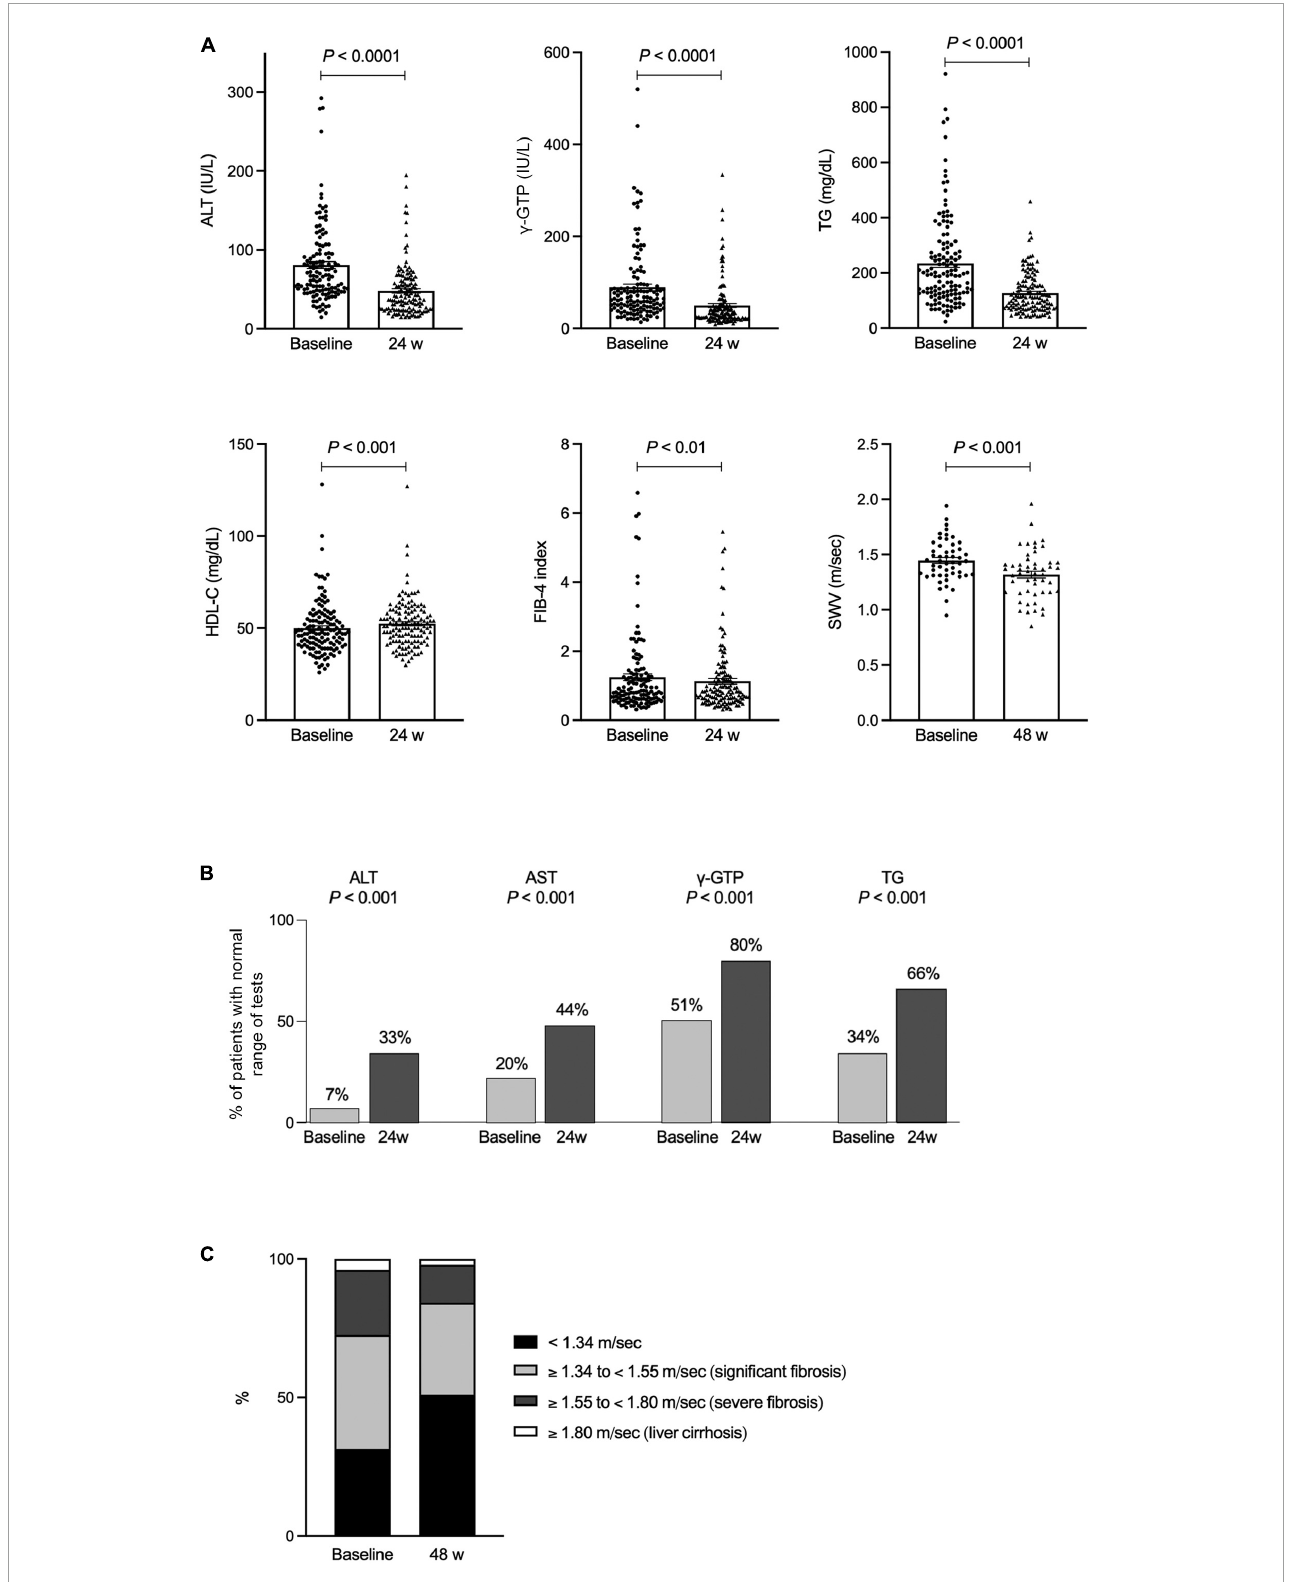
FIGURE1 (A) The changes in ALT, γ -GTP, TG, HDL-C, FIB-4 index and SWV at baseline and 24 or 48 weeks of treatment with pemafibrate. (B) Normalized ALT as well as AST, γ -GTP, and TG after 24-week treatment with pemafibrate compared to the baseline. (C) The changes in fibrosis stage estimated SWV at baseline and 48 weeks of treatment with pemafibrate. ALT, alanine aminotransferase; γ -GTP, γ -glutamyl transpeptidase; TG, triglyceride; HDL-C, high-density lipoprotein cholesterol; FIB-4, fibrosis-4; SWV, shear wave velocity; AST, aspartate